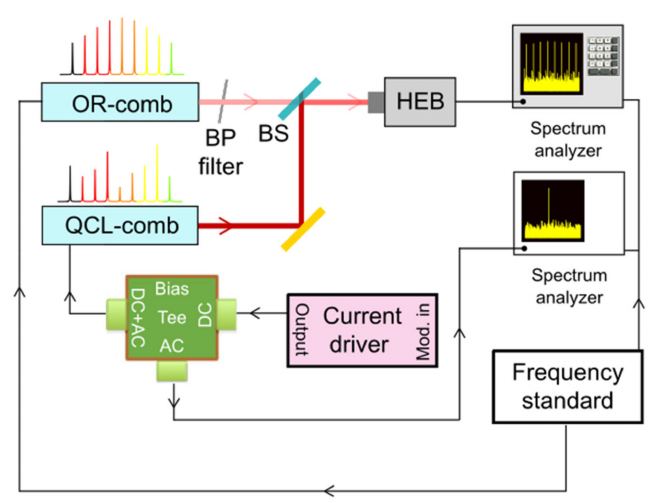
Figure 4. Experimental setup used for the characterization of the DFG QCL-comb. The beams of the optically rectified comb (OR-comb) and QCL-comb are superimposed by means of a beam splitter (BS) and then mixed on a fast detector (HEB: Hot-electron bolometer). The HEB signal is acquired on a spectrum analyzer (Tektronics RSA5106A), and the intermodal beatnote (IBN) is acquired on a second spectrum analyzer (Rohde Schwarz FSW 26.5 GHz). The OR-comb and both spectrum analyzers are frequency-referenced to the primary frequency standard. BP filter: Band-pass